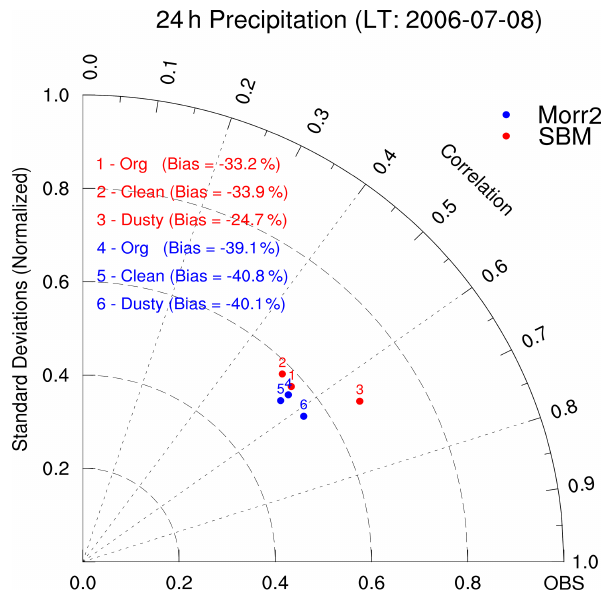
Figure 3. Taylor diagram showing spatial correlations coeffi- cients ( r ), standard deviations (SDs), and bias (%) between simu- lations by the six numerical runs and the observation of the 24h accumulated precipitation.